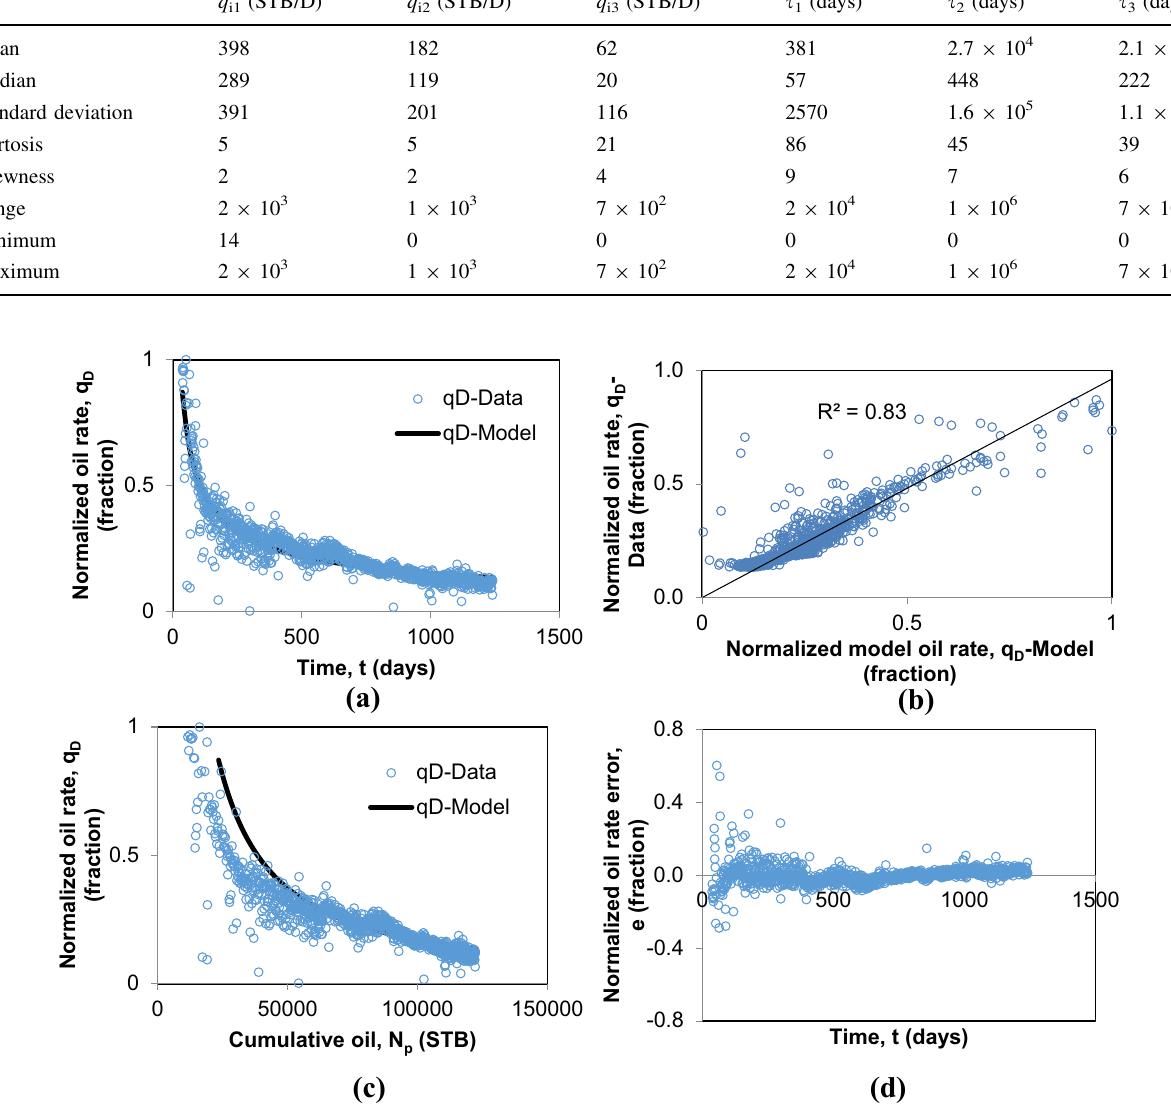
Fig. 5 Example application of the logistic growth model. a Rate– time plot for the data and model history match and c rate–cumulative plot for the data and model history match. b Cross-plot of the